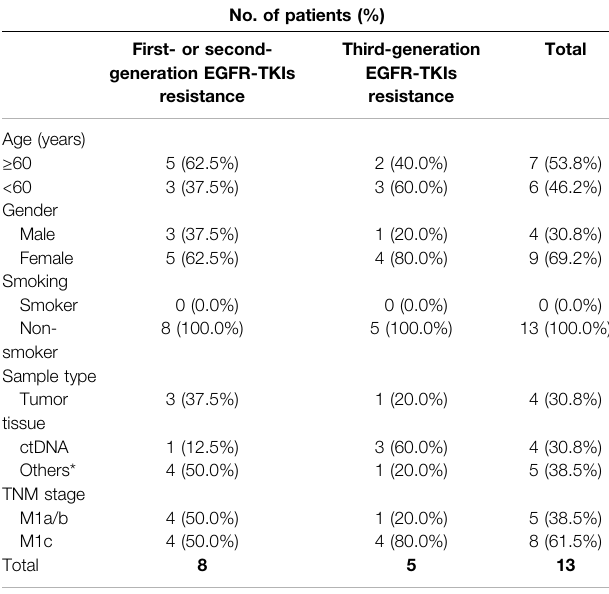
TABLE 1 | Clinicopathological characteristics of patients with FGF3/4/19/CCND1 ampli fi cation among 285 TKI-resistance